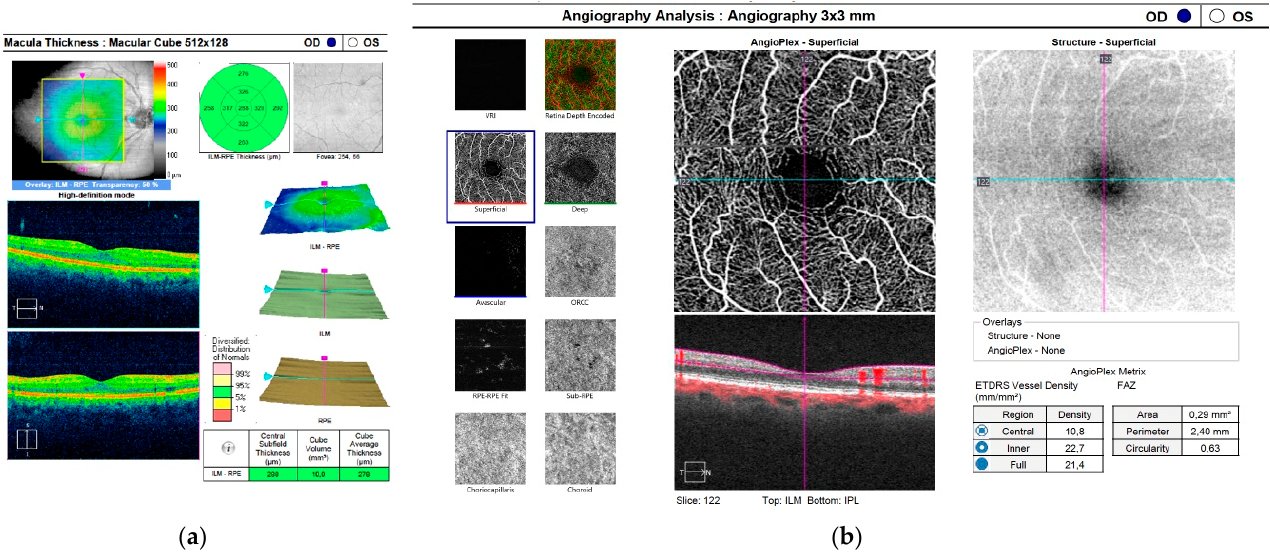
Figure 1. ( a ) Printout of the protocol used for central retinal thickness (CRT), central retinal volume (CV), and average central retinal thickness (CRTA) measurements. ( b ) Printout of the protocol for vessel density measurements.